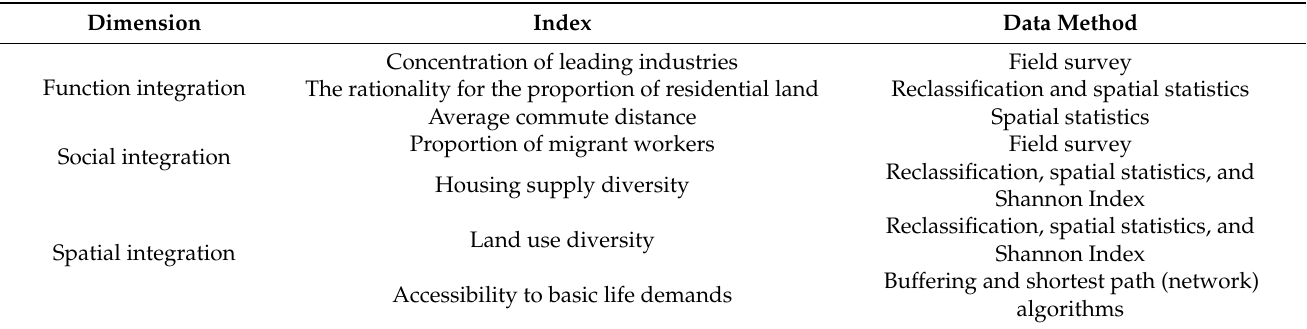
Table 4. The dimensions and index system for evaluating the level of development of city–industry integration at the industrial park